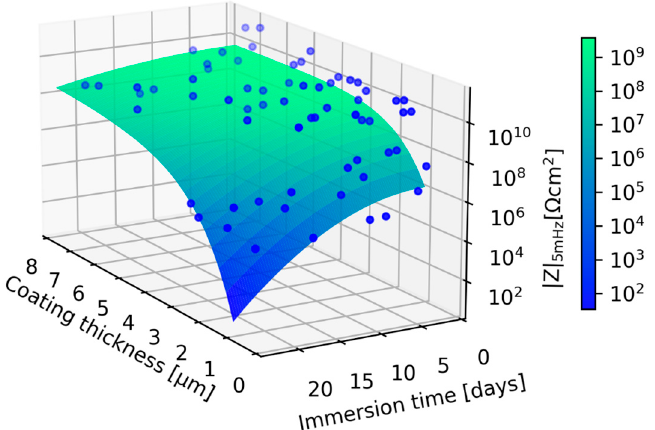
Figure 10. The impedance magnitude  Z  5 mHz is presented for coatings of di ff erent thicknesses (1–8 µm) deposited on structural steel and cured at 180 °C vs. immersion time in 3.5 wt.% NaCl. (1–8 µ m) deposited on structural steel and cured at 180 ◦ C vs. immersion time in 3.5 wt.%